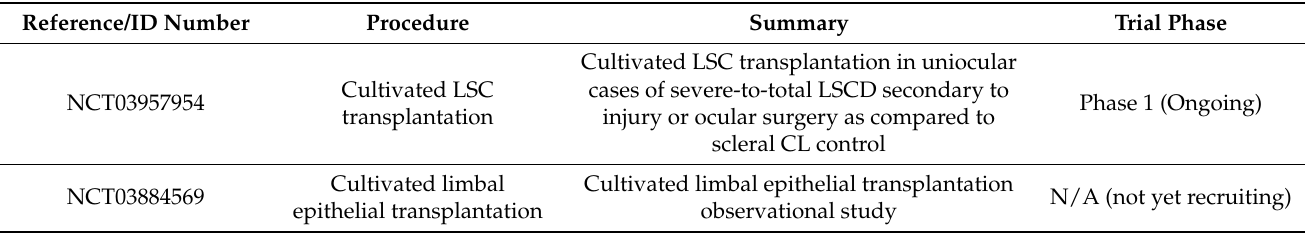
Table 5. Ongoing and upcoming clinical trials involving limbal stem